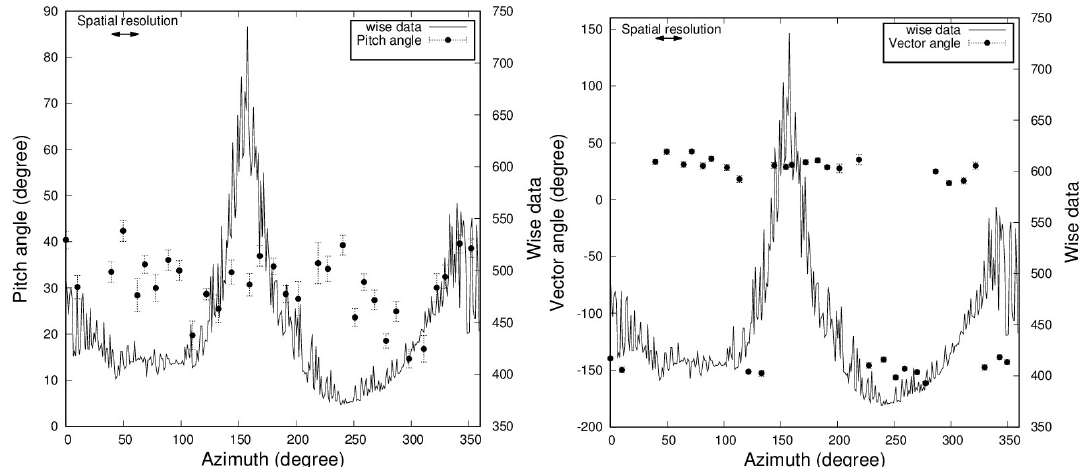
Figure 6. Azimuthal variations of magnetic pitch angle ( right ) and vector angle ( left ) of NGC6946, respectively. The solid line denotes the brightness of the WISE image and the peaks correspond to positions of the spiral arms. The error bars represent the error of the polarization angle of the X band (cid:113) ( δχ ) 2 ∆ Q 2 + ( δχ ) 2 ∆ U 2 . Plotted dots are obtained from the annulus between calculated using ∆ χ = δ Q δ U the circles with radii of 0.68 and 2.04